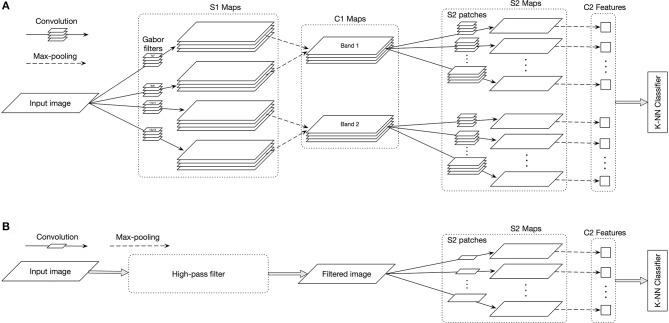
(A) The overall sketch of Model I for processing the HSF bands. In the S1 layer, the input image is convolved with Gabor filters (four orientations) in the first four high spatial frequency sizes (i.e., HSF). C1 layer pools each of the two consecutive S1 maps. During the learning, S2 layer extracts patches of different size from the C1 output over different input images. During the test phase, the S2 patches are convolved with the output of the C1 layer. Then the C2 layer applies a global max operation over the output of each S2 output map. Finally a K-NN classifier detects the category of the input image based on the location of its C2 vector and nearest training C2 vectors. (B) The overall sketch of Model II for processing the HSF band. The input images are first filtered into the HSF band and then S2 patches are extracted from the filtered images. The remaining parts are similar to Model I. For both models, the same procedures but with different filters in first layers are used for the ISF and LSF bands.